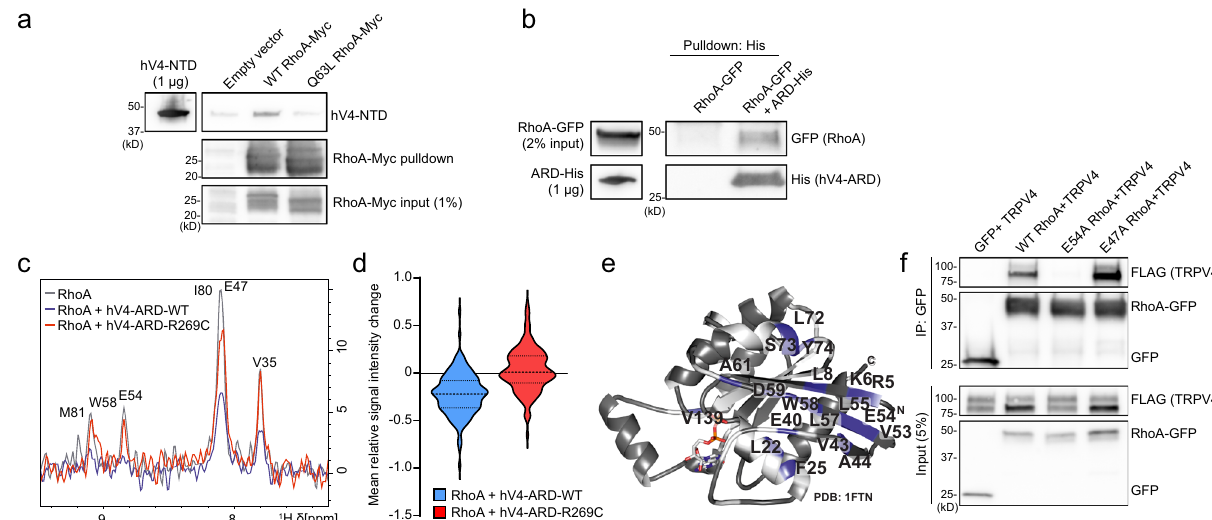
Fig. 3 The TRPV4 ARD is suf fi cient for RhoA binding. a RhoA-WT-Myc or RhoA-Q63L-Myc were immunopuri fi ed from HEK293T cells and then incubated with 10 µ g puri fi ed human TRPV4 N-terminal domain (hV4-NTD). hV4-NTD is pulled down by WT RhoA, but not RhoA-Q63L. b Pull-down of lysate from cells expressing RhoA-GFP with puri fi ed human His-tagged TRPV4 ARD (hV4-ARD-His) bound to NiNTA beads demonstrates direct interaction of RhoA with the TRPV4 ARD. c Representative 1D projection of 1 H resonances from 2D 1 H – 15 N NMR spectra of 15 N-RhoA (gray) and in the presence of either hV4-ARD-WT (blue) or hV4-ARD-R269C (red). Stronger signal decreases for RhoA in the presence of WT ARD vs. neuropathy mutant indicate decreased interaction between RhoA and mutant ARD. d Violin plot showing integral changes of the 145 assigned backbone amide RhoA resonances in the presence of unlabeled hV4-ARD-WT or hV4-ARD-R269C. Greater average signal intensity changes in the RhoA spectra with hV4-ARD- WT are indicative of increased complex formation with WT as compared to the neuropathy mutant. Dashed lines represent means, dotted lines represent quartiles. e NMR signal intensity changes in the presence of WT TRPV4 ARD were mapped onto the crystal structure of GDP-bound human RhoA (PDB: 1FTN) 92 . Residues with signi fi cant decreases in signal intensity (labeled with residue position and indicated in blue) are predominantly localized in the RhoA switch regions. White portions correspond to residues for which no peaks could be identi fi ed in the measured 1 H – 15 N 2D HSQC spectra. f Co- immunoprecipitation of MN-1 cells transfected with TRPV4-FLAG and WT RhoA-GFP, E54A RhoA-GFP, or E47A RhoA-GFP demonstrates disruption of TRPV4 – RhoA interaction with mutation of the E54 residue of RhoA. Further details regarding the number of times experiments were repeated are presented in “ Methods ” under “ Statistics and reproducibility ”